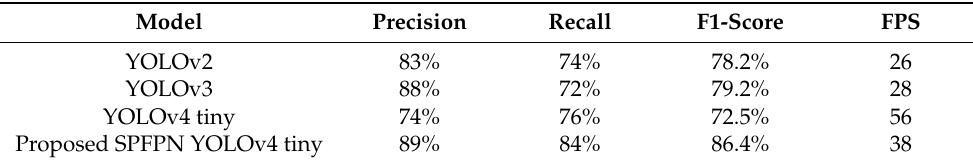
Table 6. Performance comparison on the pothole test